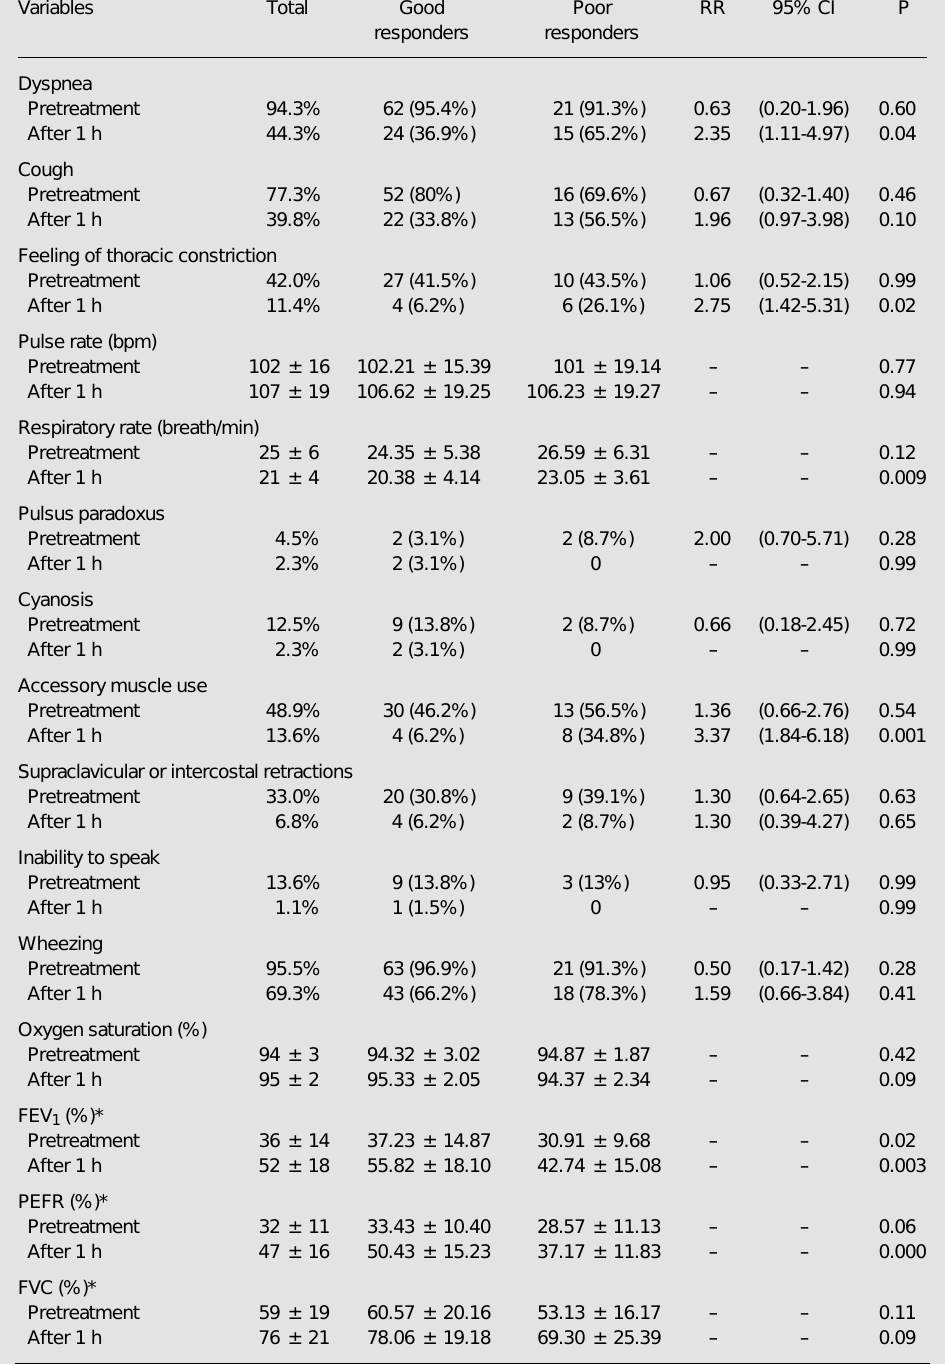
Table 2. Clinical and pulmonary function measures obtained before and 1 h after